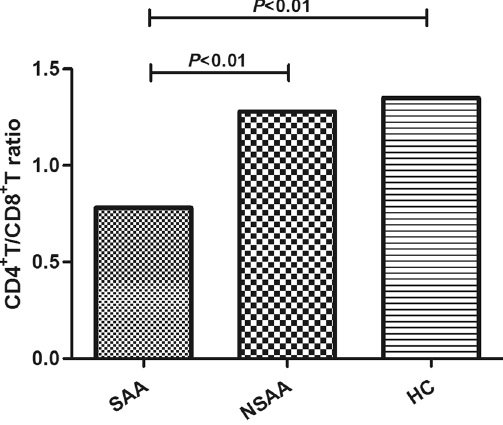
Figure 2. Circulating CD4 + /CD8 + T-cell ratios in patients with aplastic anaemia and the healthy controls. SAA: severe aplastic anaemia; NSAA: non-severe aplastic anaemia; HC: healthy